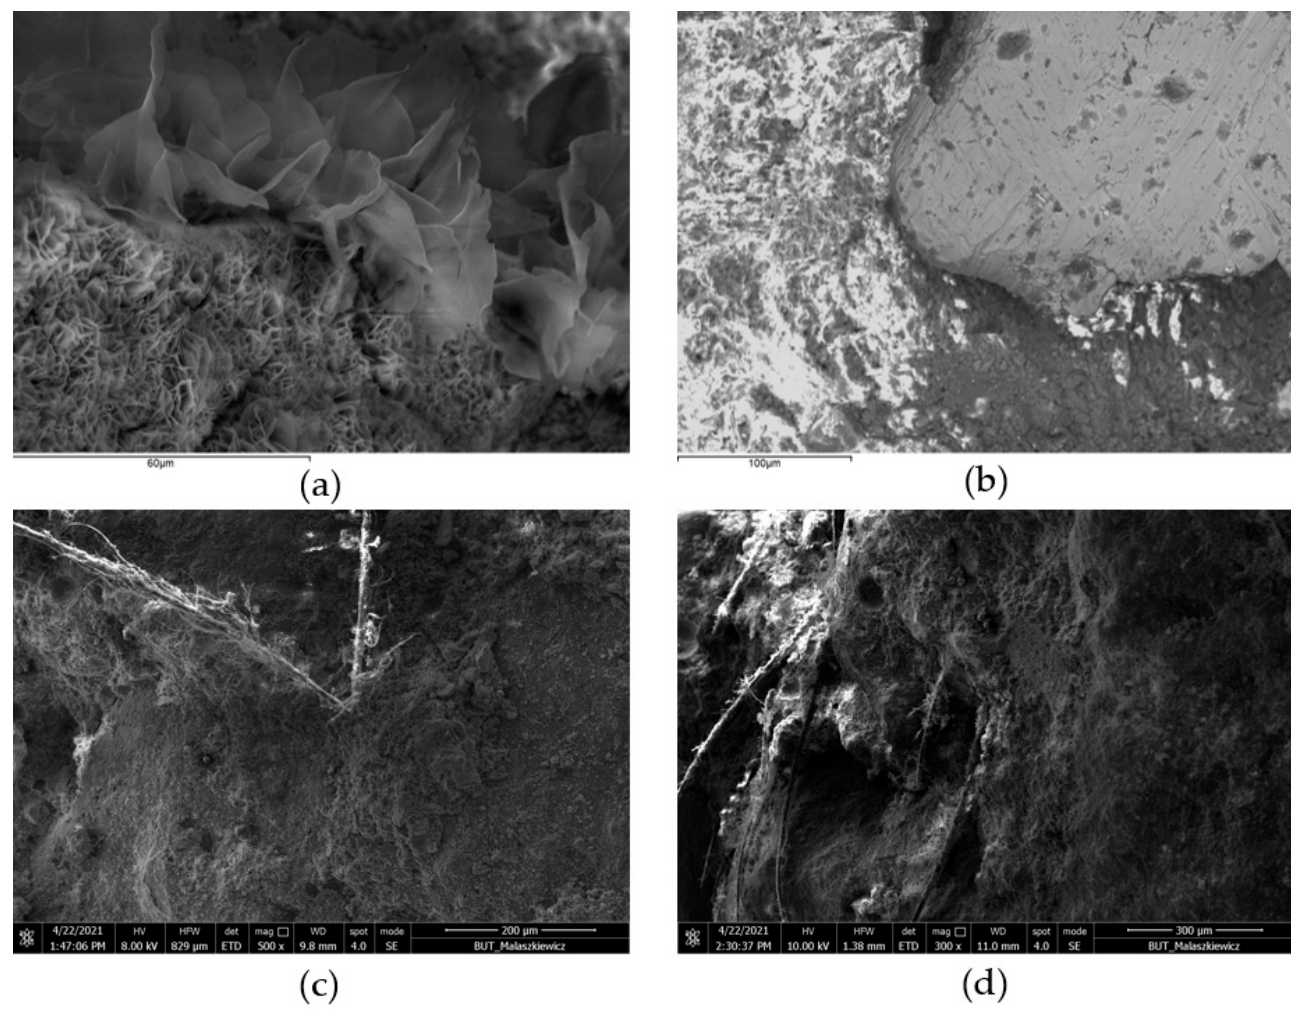
Figure 5. Scanning electron microscopy: images ( a , b ) corresponding to mortar made with recycled concrete aggregate without fibers RA ‐ 1:3; images ( c , d ) corresponding to mortar with recycled concrete aggregate and aramid fiber RA ‐ 1:3 ‐ AF.